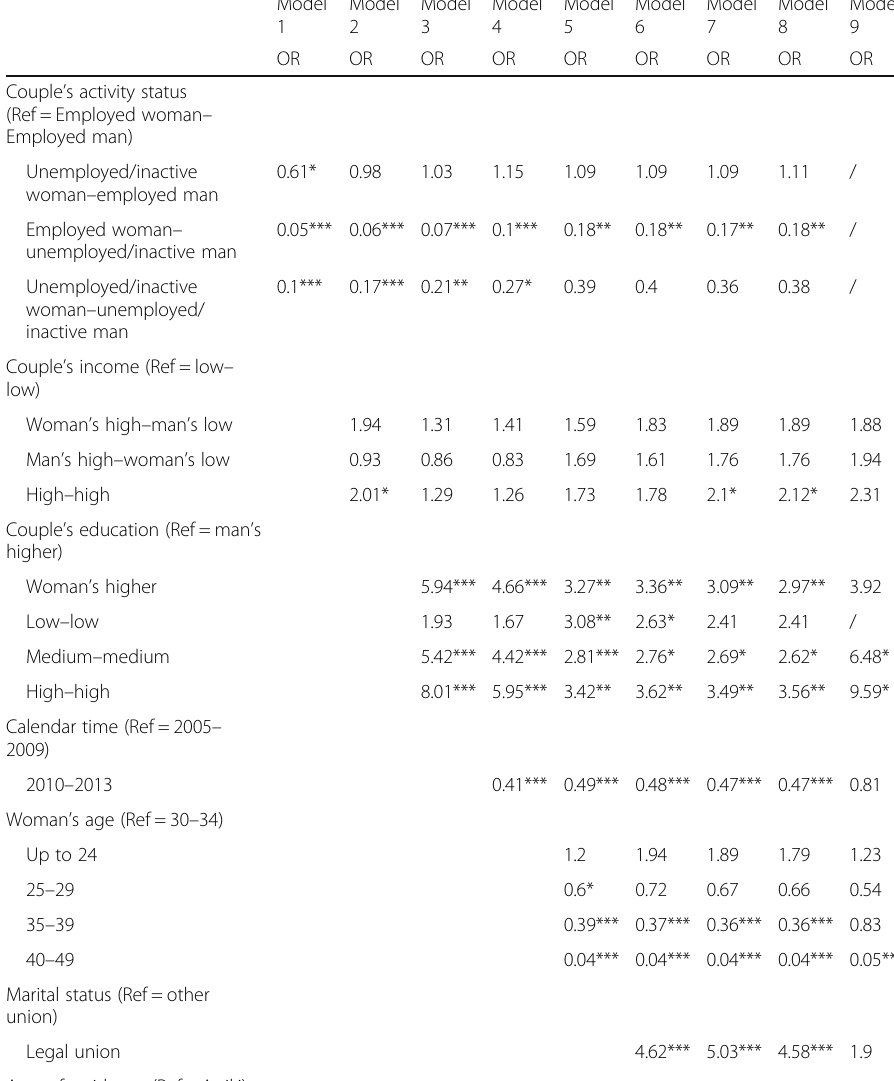
Table 4 Transition to first child in Greece, nested random effects models (without